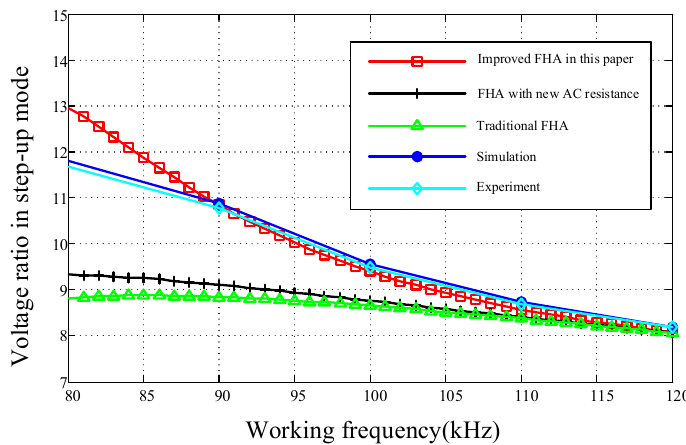
Figure 13. Voltage gain in step-down mode.